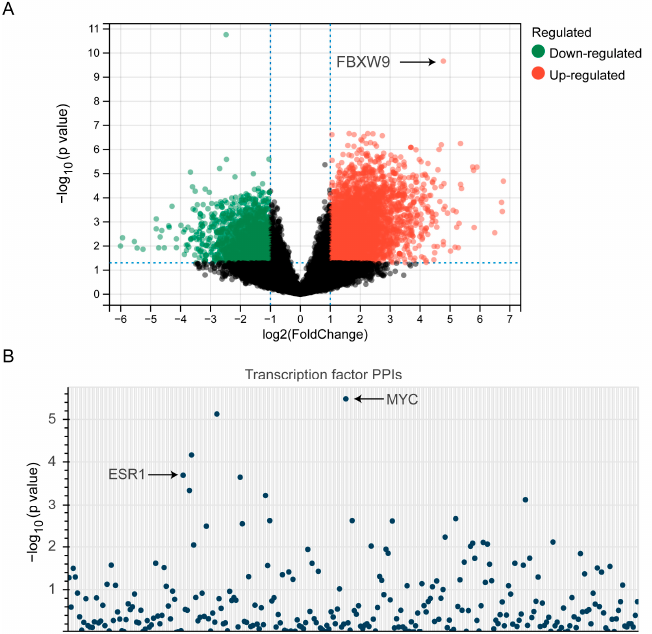
Figure 7. Analysis of genes regulated by FBXW9 in breast cancer. ( A ) The differentially expressed genes between FBXW9 high- and low-expression groups were analyzed. ( B ) The transcription factors regulating the differentially expressed genes were analyzed.